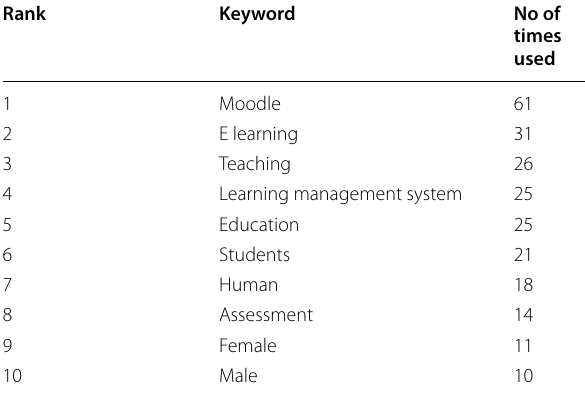
Table.5 Top 10 popular